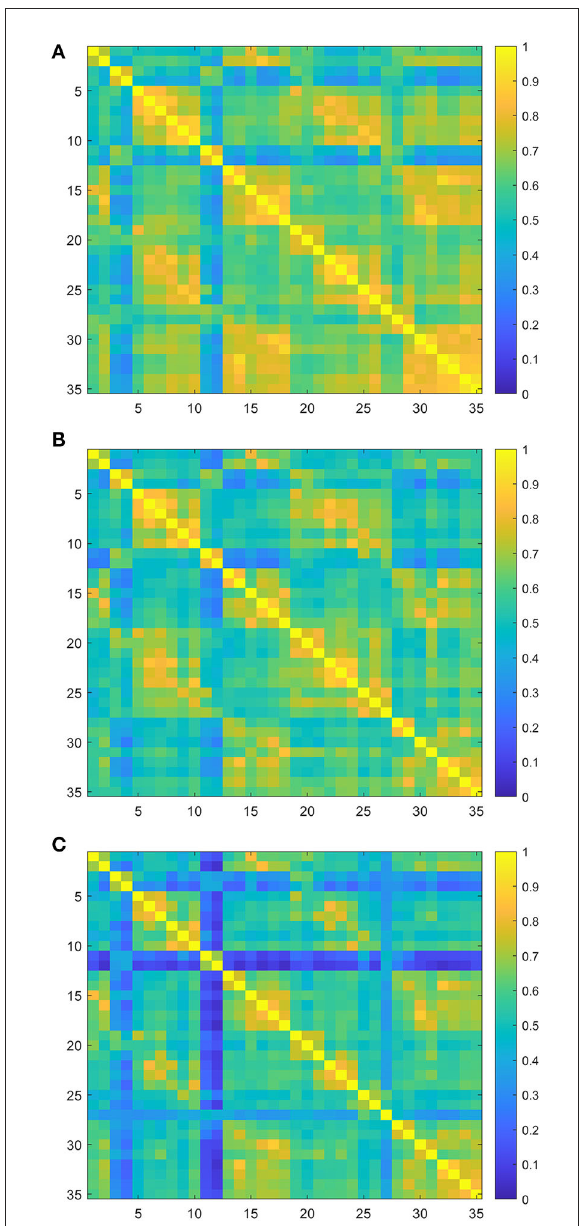
FIGURE2 Group-averaged resting-state functional connectivity (RSFC) matrix diagram. Axes represent the channels. Each channel with its correlation coefficient set at zero (the diagonal line). (A) RSFC matrix of the mild group. (B) RSFC matrix of the moderate group. (C) RSFC matrix of the severe group.